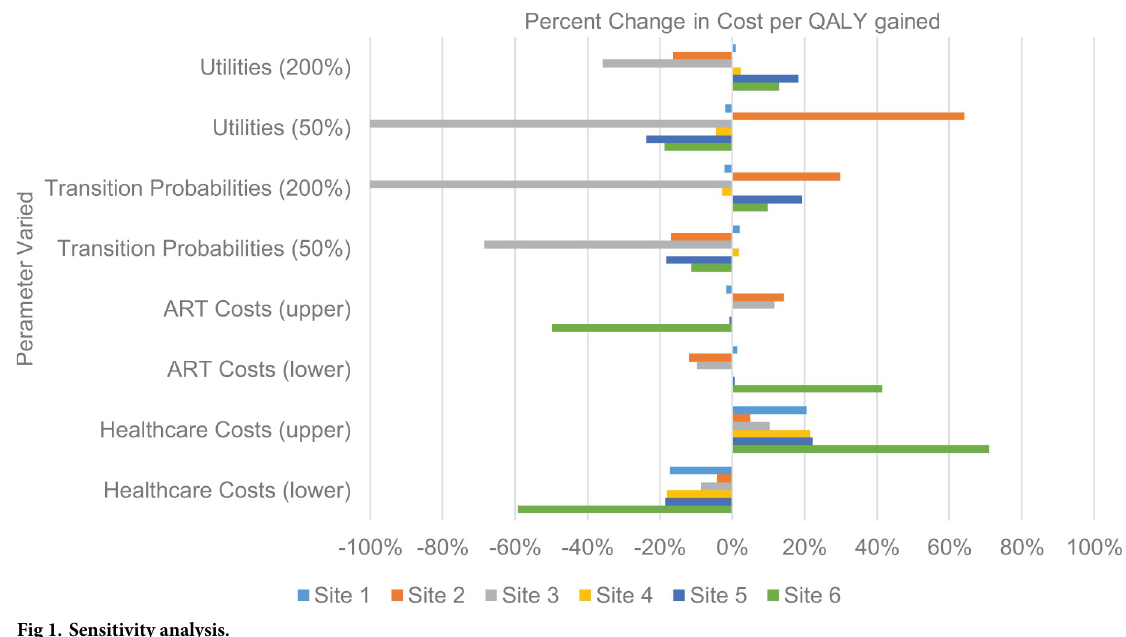
Fig 1. Sensitivity